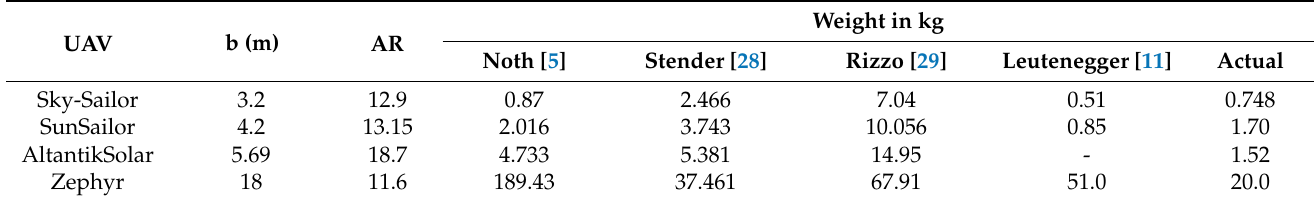
Table 1. Comparison of structural weight estimation